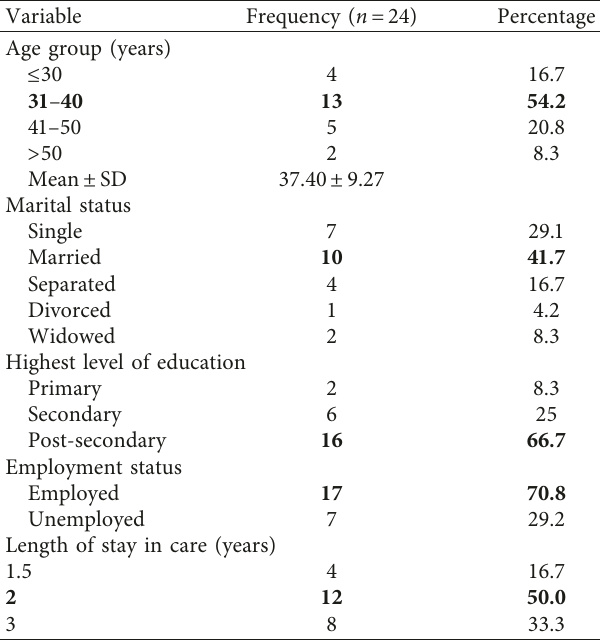
Table 2: Participant